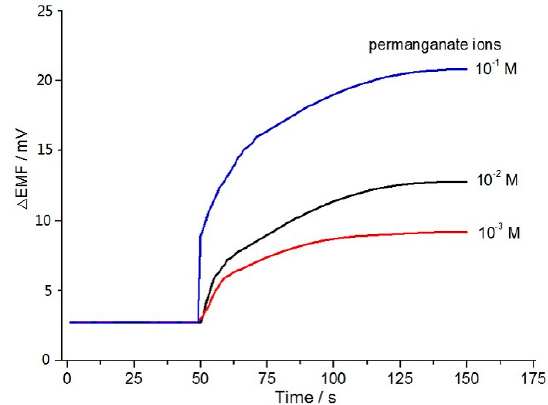
Figure 3. The effect of concentration of the inner permanganate ions on the potential changes.